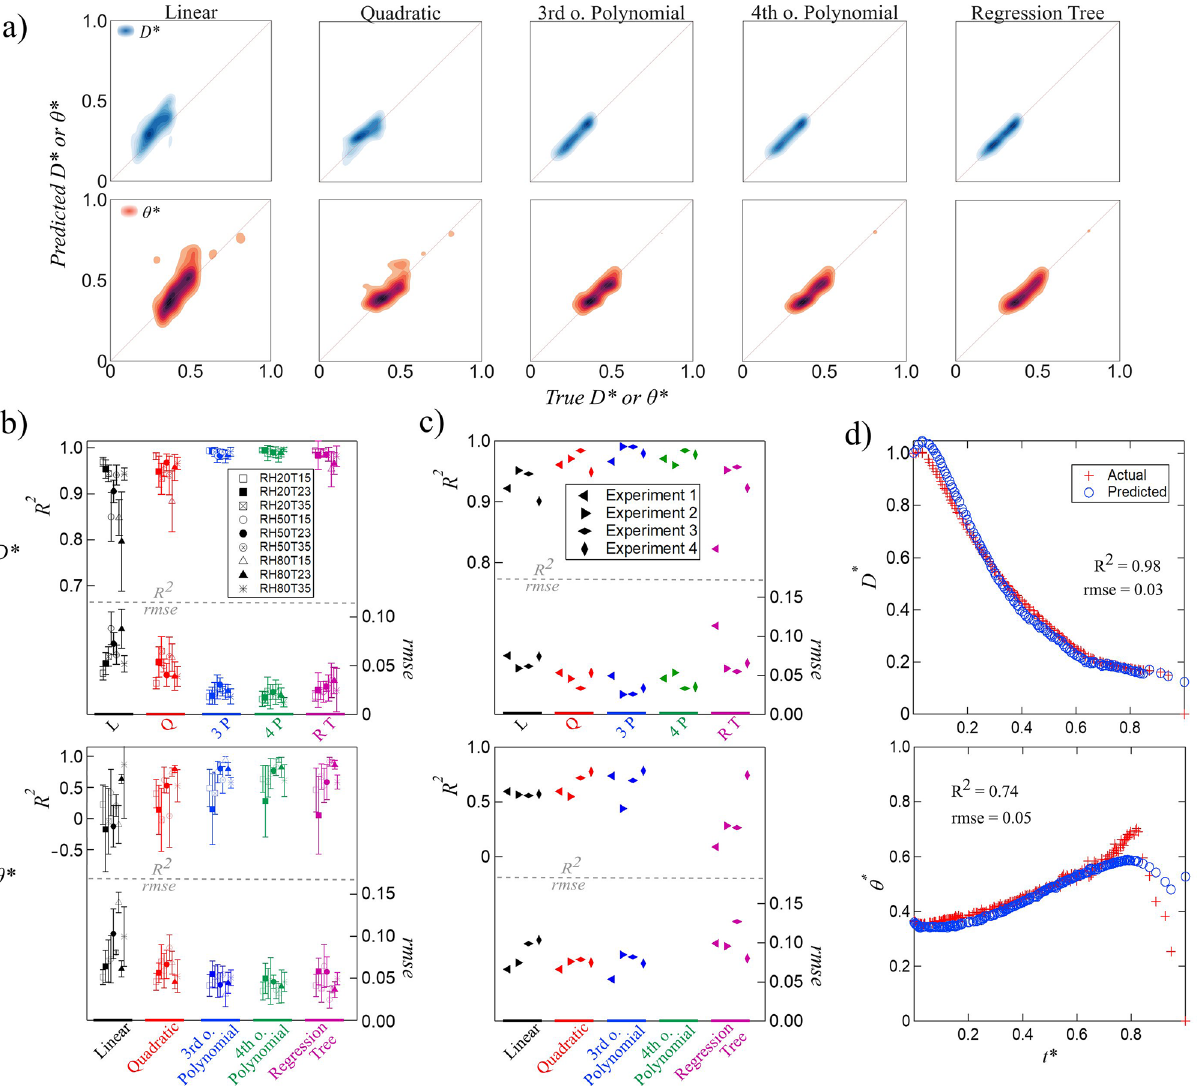
Figure 4. Diameter (D*) and contact angle (θ ∗ ) regression results: ( a ) test set; ( b ) validation set; ( c ) estimation set; ( d ) diameter estimation with quadratic regression for E3 (top) and contact angle estimation with third-order polynomial regression for E1